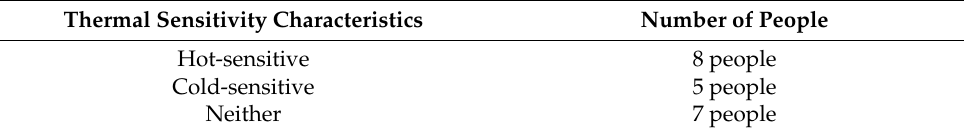
Table 7. The thermal sensitivity characteristics.